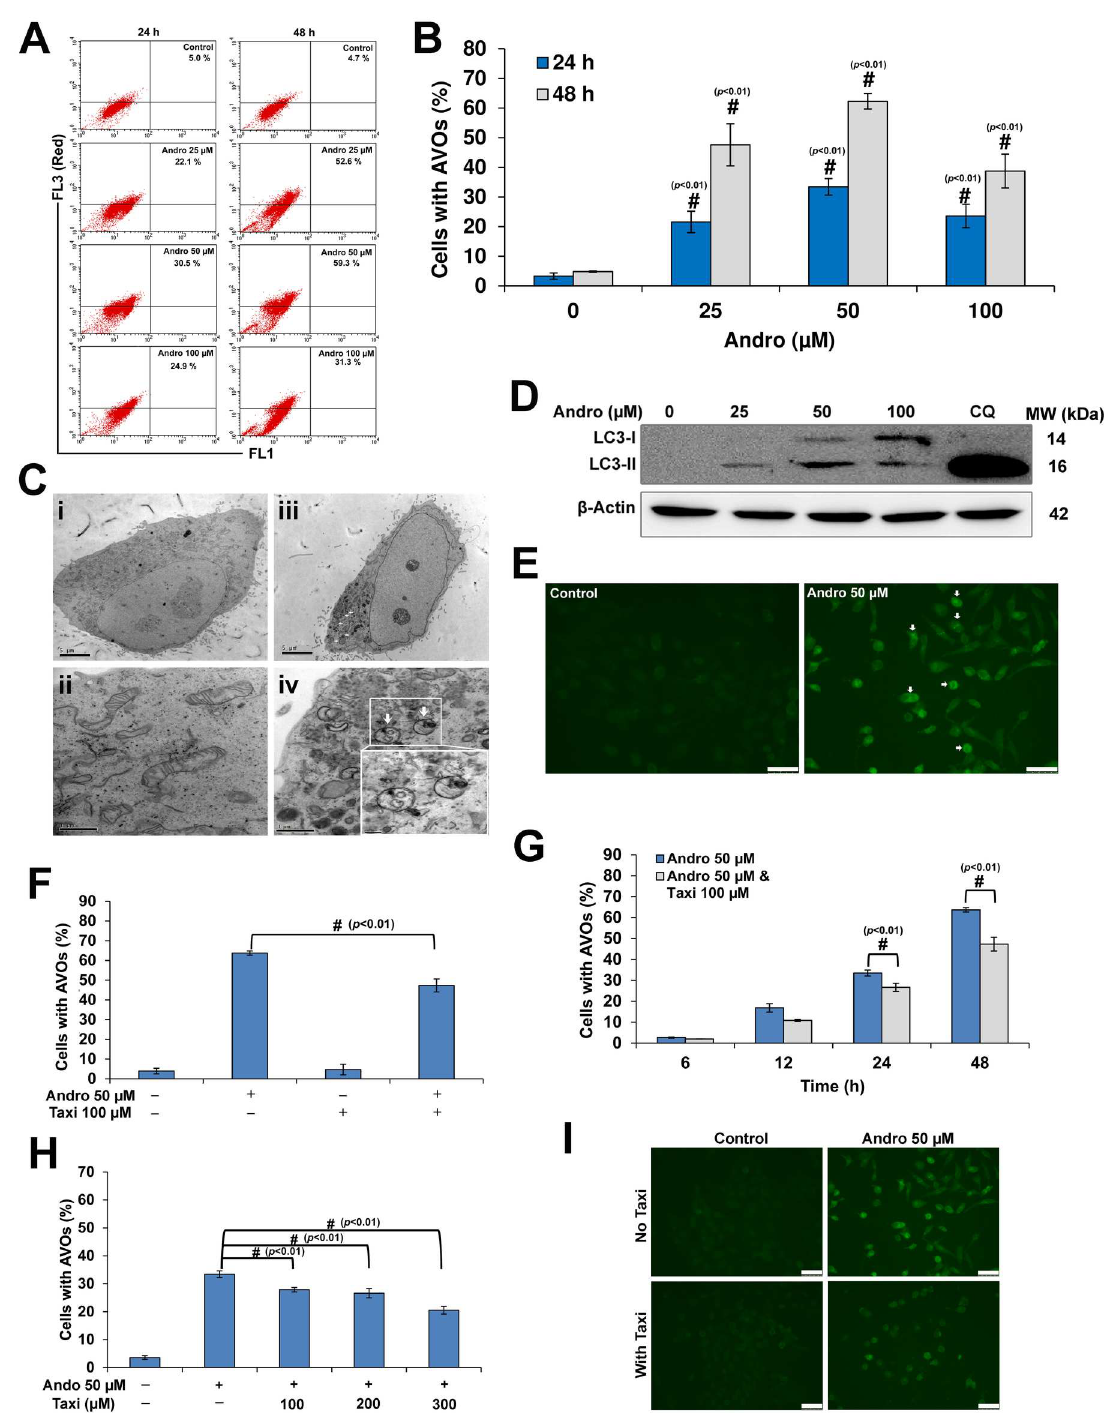
Fig 3. Andro induced autophagy in HeLa cells while Taxi diminished it. (A) A representative flow cytometric dot plots showingthe increase in the AVOs percentage in HeLa cells treated with different concentration of Andro for 24 and 48 h